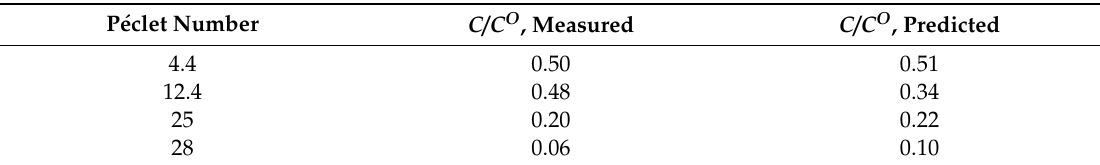
Table 1. Relative concentration as a function of the P é clet number in biocatalytic plane-sheet membrane reactor during hydrolysis of oleuropein [24] ( C O = 2.5 mol / m 3 . K M = 3.8 mM; v max = 0.081 mol / m 3 s;